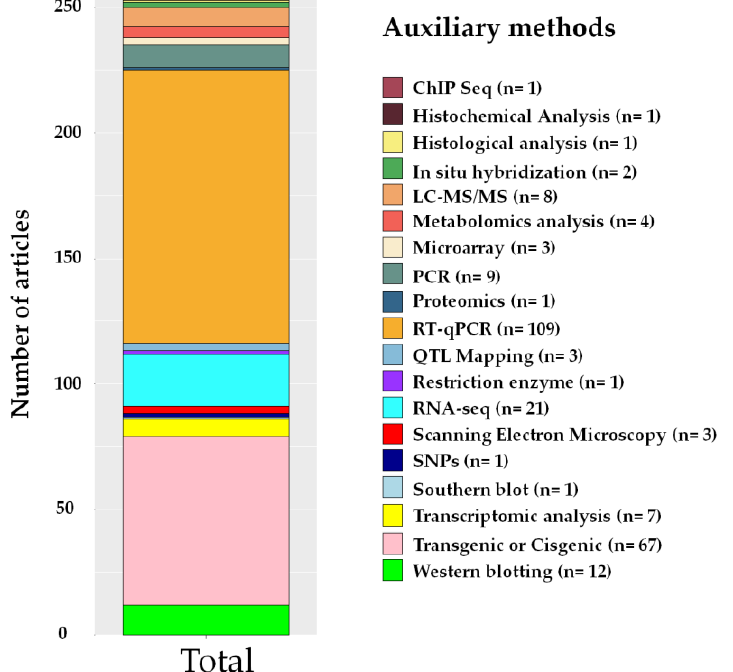
Figure 10. Auxiliary tools used with the CRISPR/Cas technique for comparison between knockout with the control and/or with the overexpression of mutants identified in articles on tolerance to abiotic stresses in the last seven years. The frequency was determined considering that more than one auxiliary method was used per article, n = number of articles.